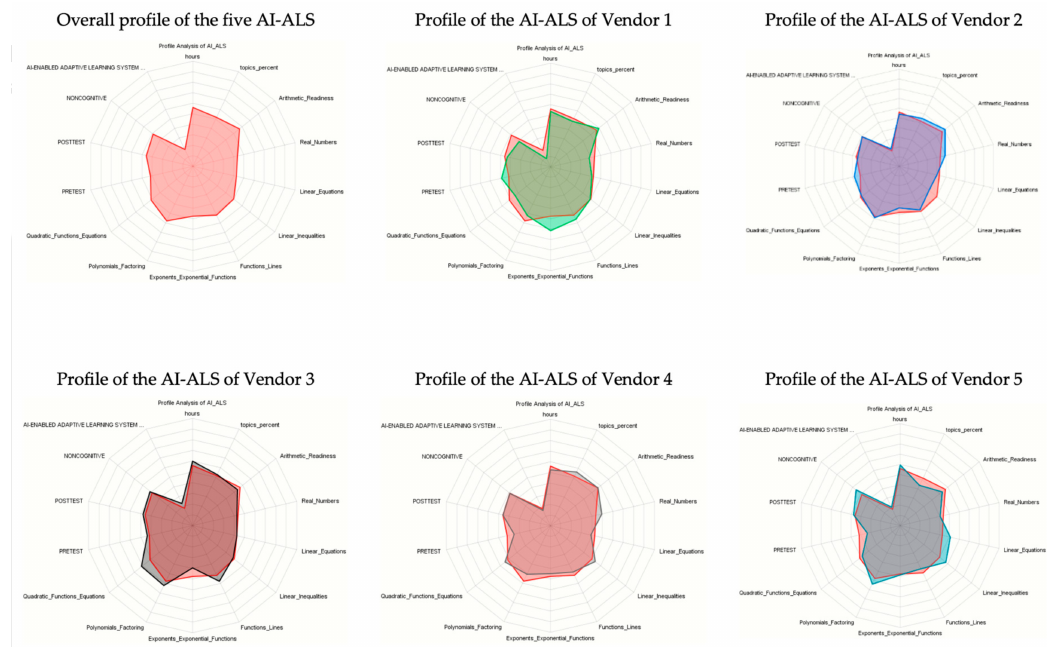
Figure 4. Profiles of five di ff erent AI-ALS, each from a di ff erent vendor, superimposed on top of the overall